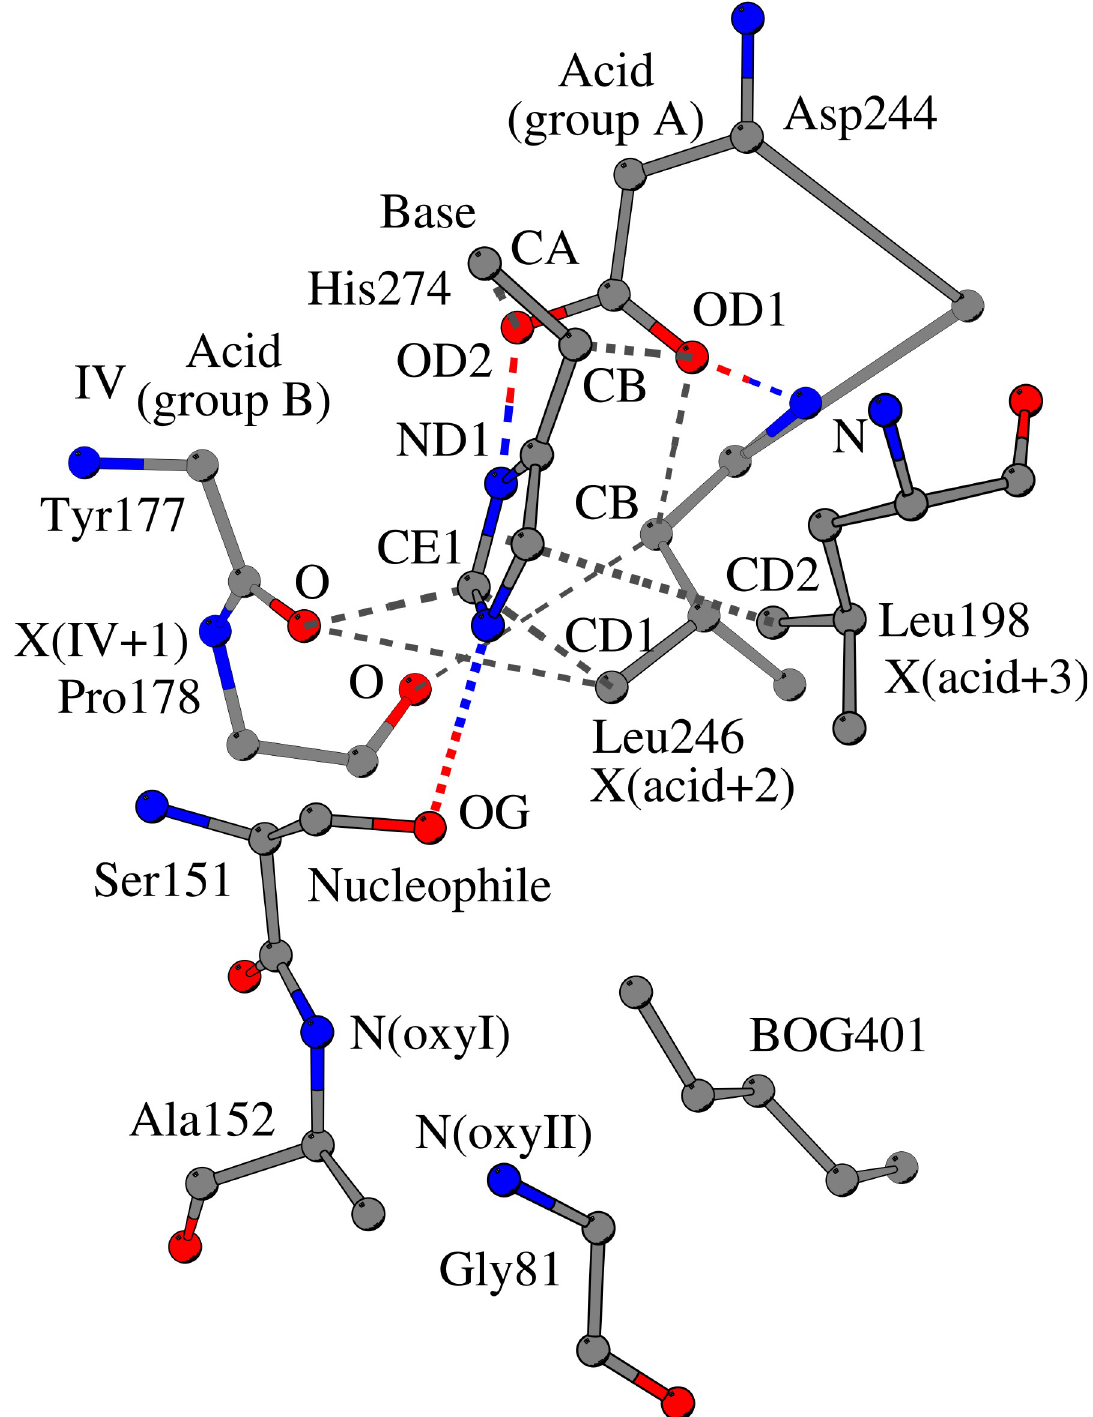
Fig 3. Coordination of the imidazole ring of the catalytic histidine in the carboxylesterase SshEstI (PDB ID:3WJ1). The optimal arrangement of catalytic residues requires the proper positioning of the imidazole ring of the catalytic histidine (“Base”, His274 in SshEstI) relative to the side chains of the catalytic nucleophile (“Nucleophile”, Ser151 in SshEstI) and the catalytic acid (“Acid”, Asp244 in SshEstI). The catalytic histidine is anchored to the β -sheet through its contact with Tyr177 (position IV) and is directly coordinated by the catalytic acid Asp244. The imidazole ring of the catalytic histidine is coordinated by two interactions: a hydrophobic interaction (CD1/Leu246 –CE1/His274) with Leu246 (X(acid+2)), which is located two sequence positions after the catalytic acid, and a CH– π